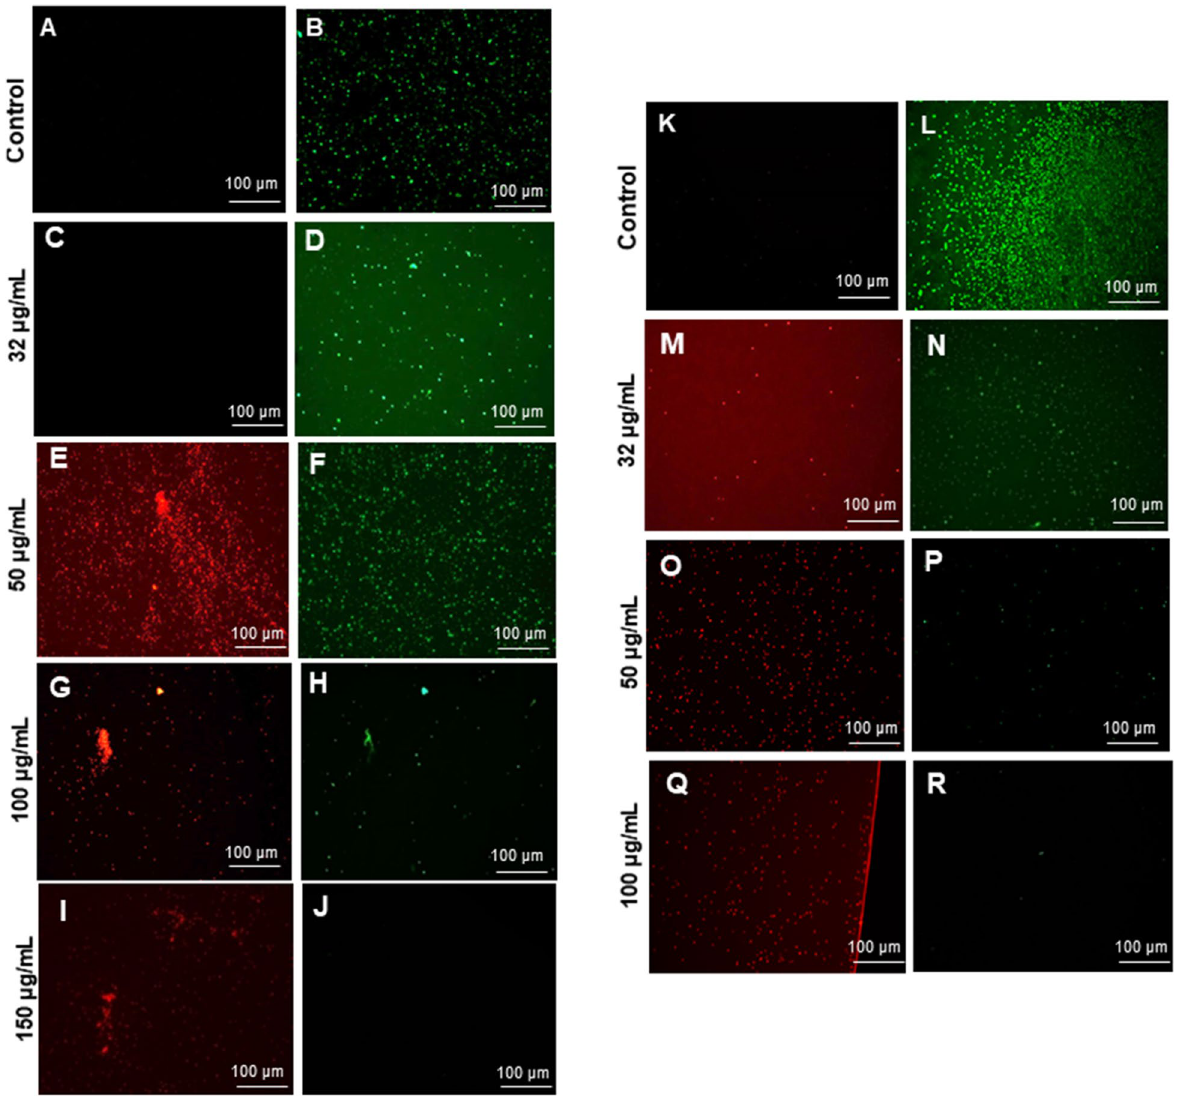
Figure 9. Live and dead staining of (A-J) P. aeruginosa and (K-R) E. coli, after treatment with LV-AgNPs at different